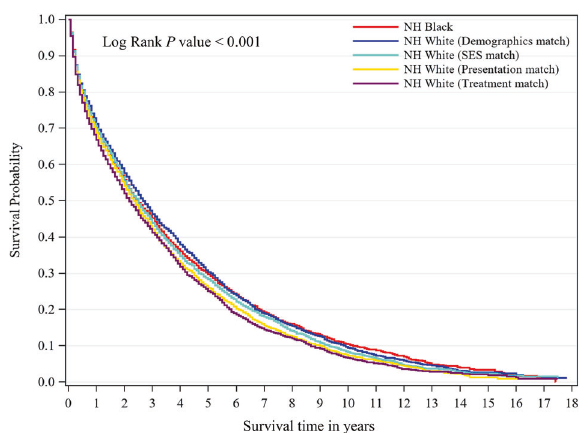
Fig. 2 Survival curve. Life-Table plot for multiple myeloma survival for the total non-Hispanic black study population ( n = 3319) and the three matched non-Hispanic white populations (each n = 3319) diagnosed between 1999 and